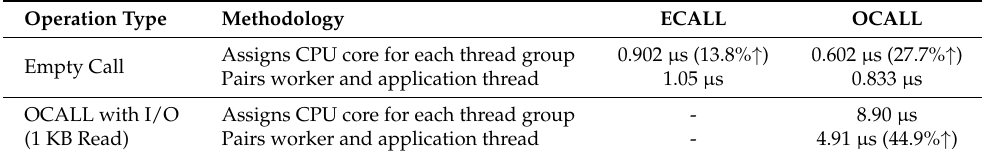
Table 1. Comparison between two core affinity strategies for switchless ECALL and OCALL. Operation Type